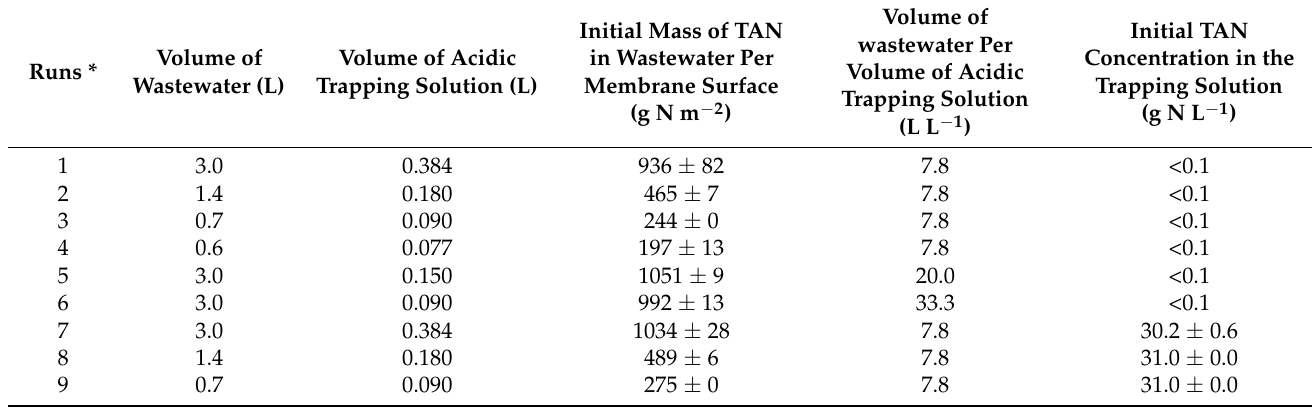
Table 1. Operating conditions for the batch runs carried